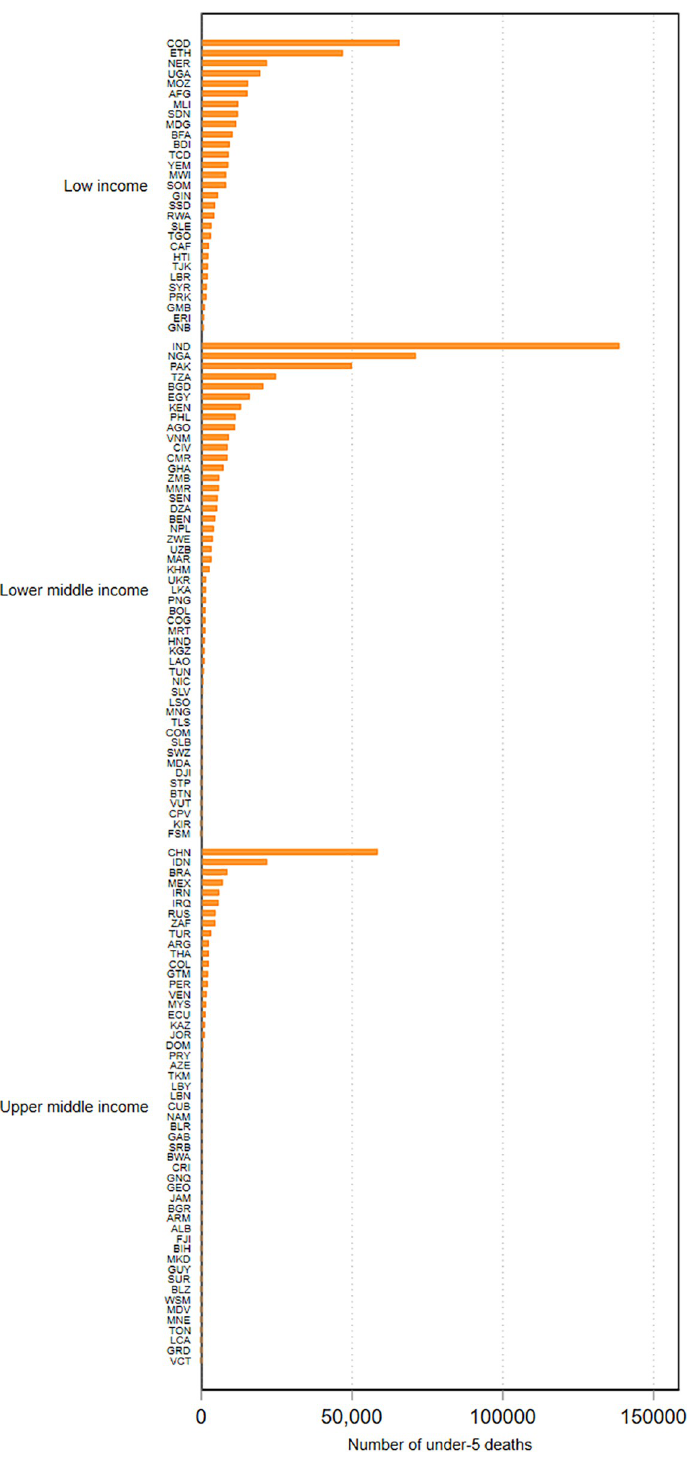
Fig 1. Changes in under-five mortality from a 15% downturn, by country and income group. Source: Authors’ elaboration.